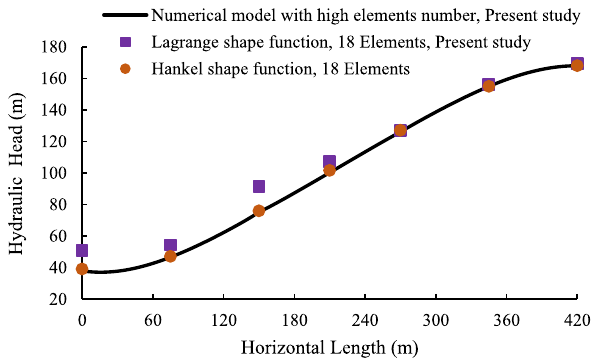
Fig.18 Contours of hydraulic head (m) for the fourth problem with 28 nodes